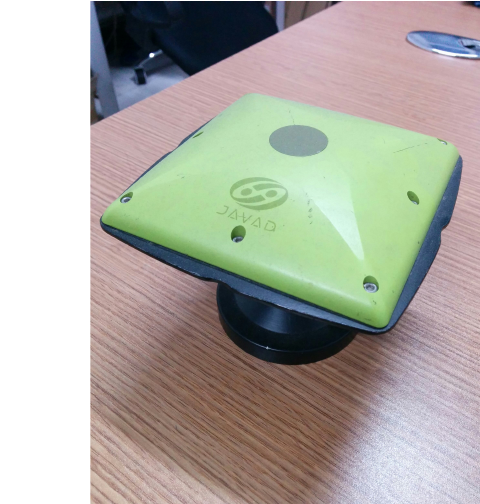
Figure 4. Schematic of the experimental setup.